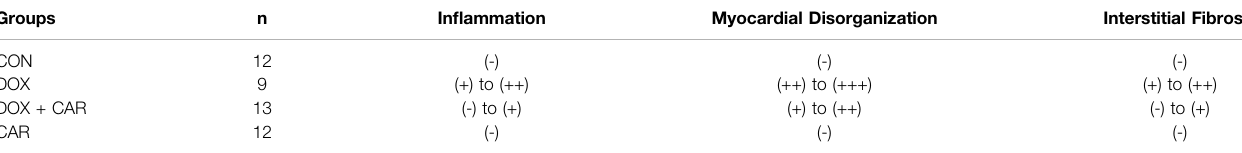
TABLE 1 | Effect of CAR on morphological changes as assessed by histopathological examination of hearts from the DOX-treated rats. Groups n In fl